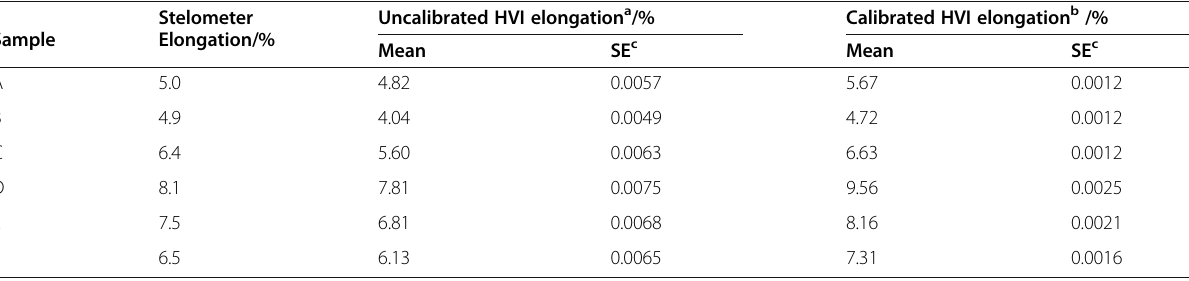
Table 1 Elongation values of round trial cotton samples